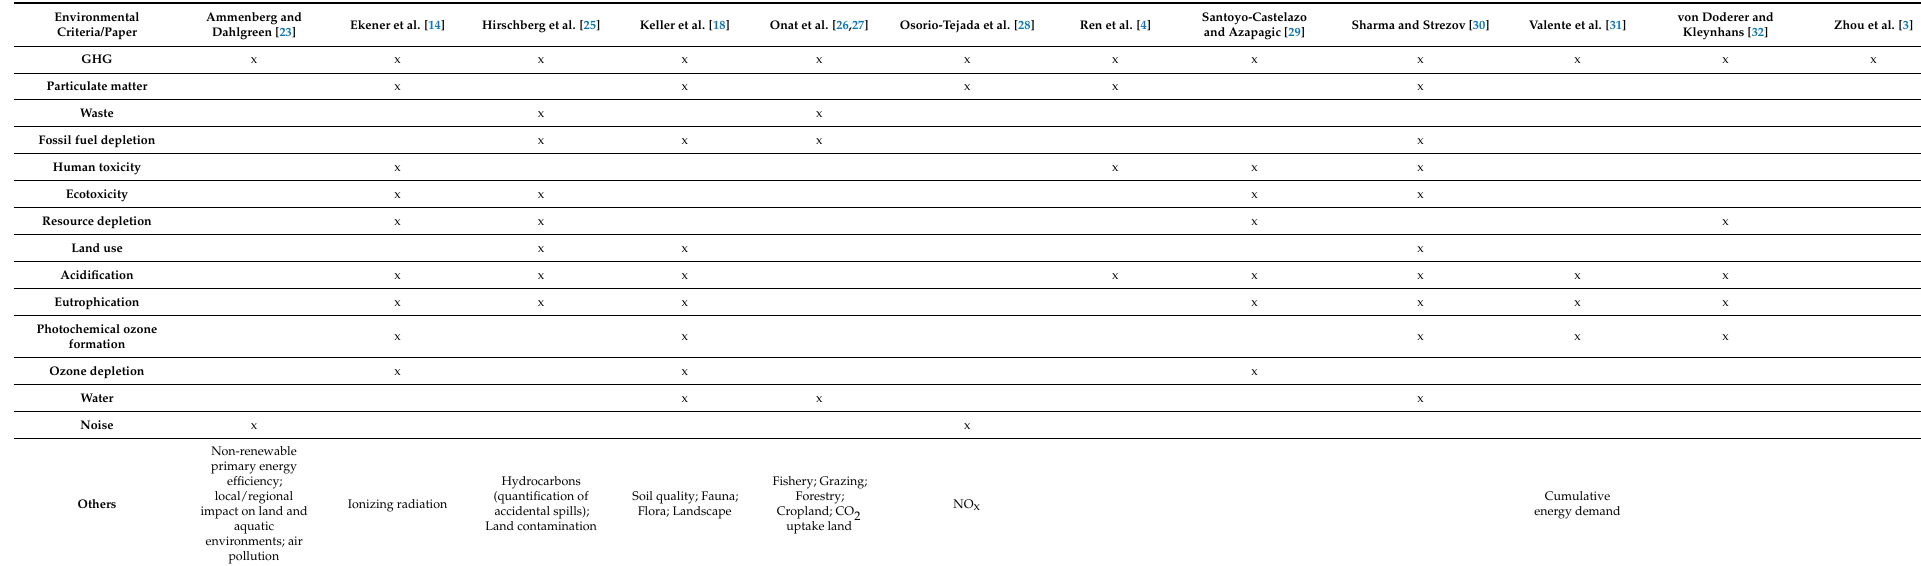
Table A1. Environmental criteria used in LCSA-related papers.